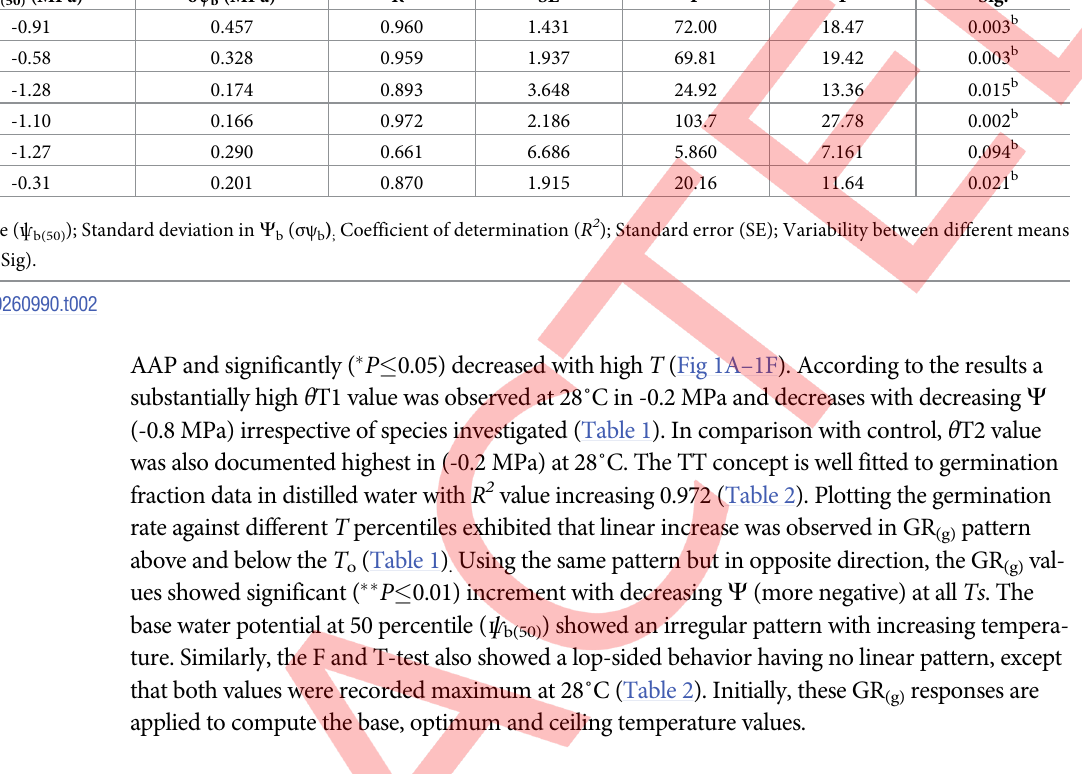
Table 2. Prediction of the hydrotime model parameters for chickpea using non-linear regression at each temperature.